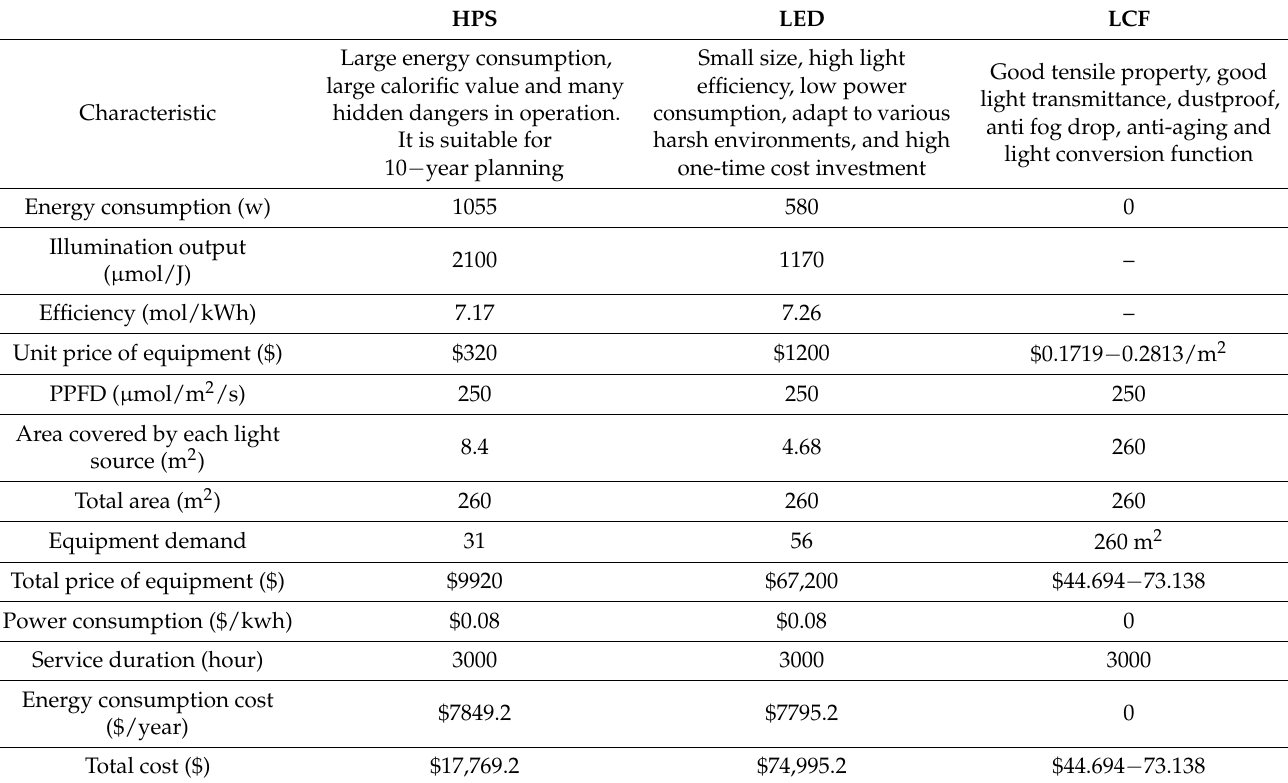
Table 9. Cost calculation of different types of fill lamps and light conversion